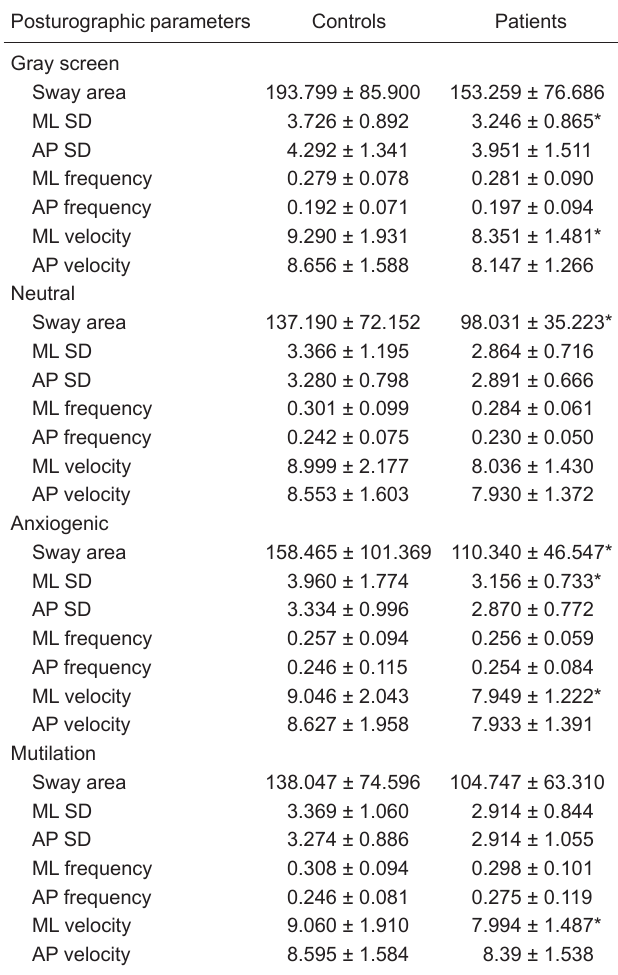
Table 1. Posturographic parameters of the